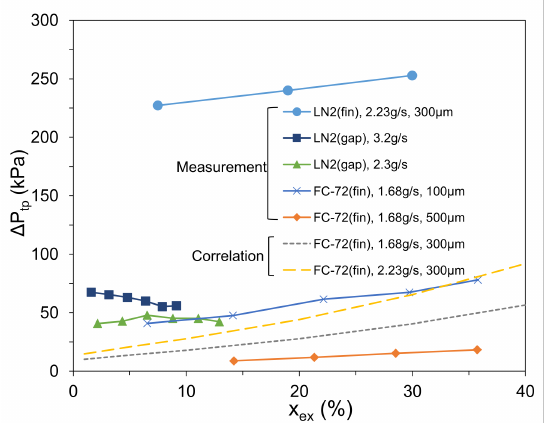
Figure 7. Base heat transfer coefficient of the cryogenic micro-pin fin and micro-gap coolers as a function of exit quality for various mass fluxes of LN 2 and FC-72.